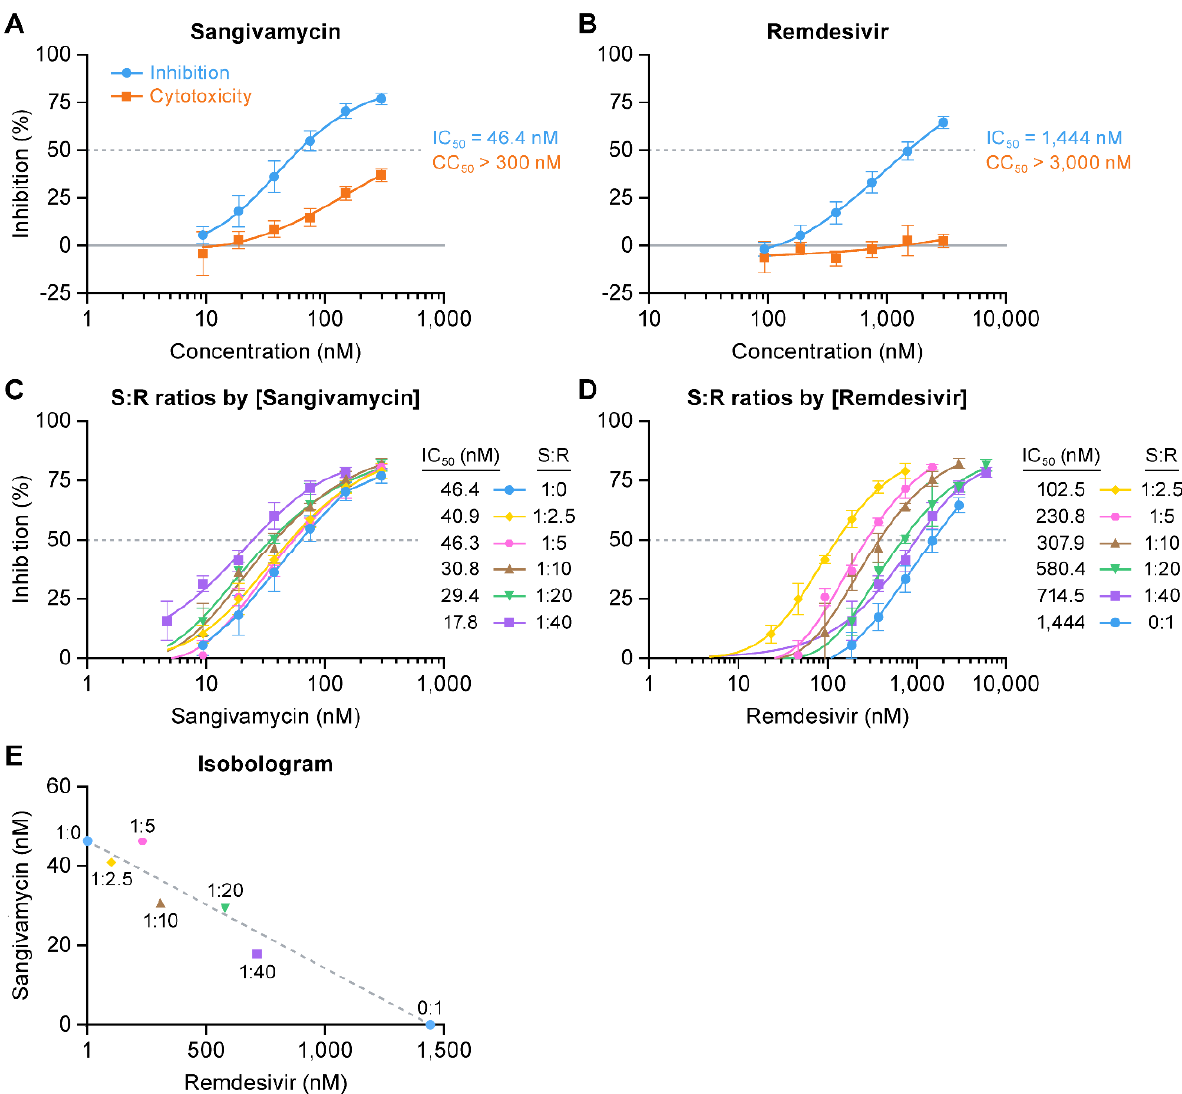
Figure 5. Sangivamycin inhibits EBOV RNA transcription/replication. Briefly, EBOV minigenome plasmids were first transfected in HEK 293T/17 cells. Cells were initially treated with ( A ) sangivamycin (300 to 9.4 nM) and ( B ) remdesivir (3000 to 94 nM) and cytotoxicity and luciferase activity were measured at 24 h. Based on the calculated IC 50 values from the single drug tests in A and B , constant ratios of sangivamycin to remdesivir (S:R = 1:2.5, 1:5, 1:10, 1:20, 1:40) were set up for drug combination studies ( C – E ). The constant ratios were plotted relative to ( C ) sangivamycin concentration (1:0 represents sangivamycin alone from A ) and ( D ) remdesivir concentration (0:1 represents remdesivir alone from B ). ( E ) The isobologram shows the IC 50 values calculated from the curves in C and D plotted on the y axis (values from C ) and x axis (values from D ) to assess the constant ratios relative to the additive line (dotted line) drawn between the IC 50 values for sangivamycin and remdesivir alone calculated from curves A and B , respectively. All of the constant ratios are along the additive line within the 95% confidence interval for each point. Data for percent inhibition and cytotoxicity were determined based on a comparison to untreated negative control cells. Data represent means ± standard deviations (SD) of results from triplicate samples for the constant ratios and an n of 9 for sangivamycin- and remdesivir-alone treatments.